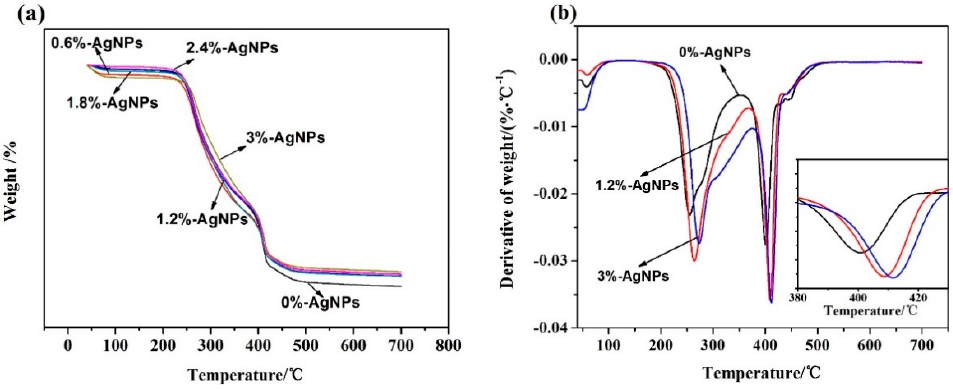
Figure 8. TG ( a ) and DTG ( b ) curves of FK/PVA/PEO composite nanofibers. Table 2. TGA data of FK/PVA/PEO composite nanofibers with different AgNPs amounts. Sample (%) T 10 (°C)